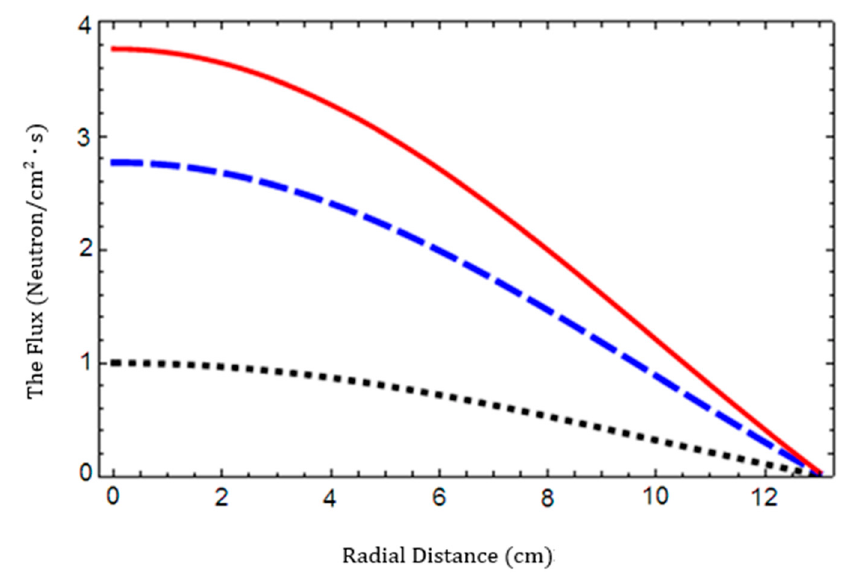
Figure 2. Two energy groups fluxes of a cylinder made of 93% enriched U. Dotted line: Thermal flux, Dashed line: Fast flux, Solid line: Total fluxes. Table 6. The normalized thermal, fast, and total fluxes values across a cylindrical geometry.